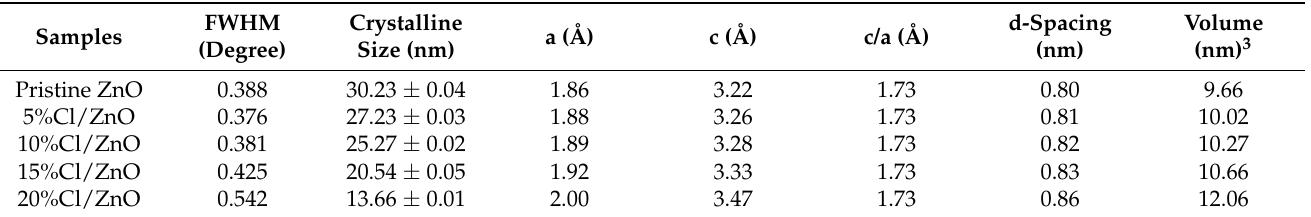
Table 1. Lattice parameters, broadening width at half maximum, crystalline size d-spacing, volume of synthesized pristine and Cl − -doped ZnO nanostructures.